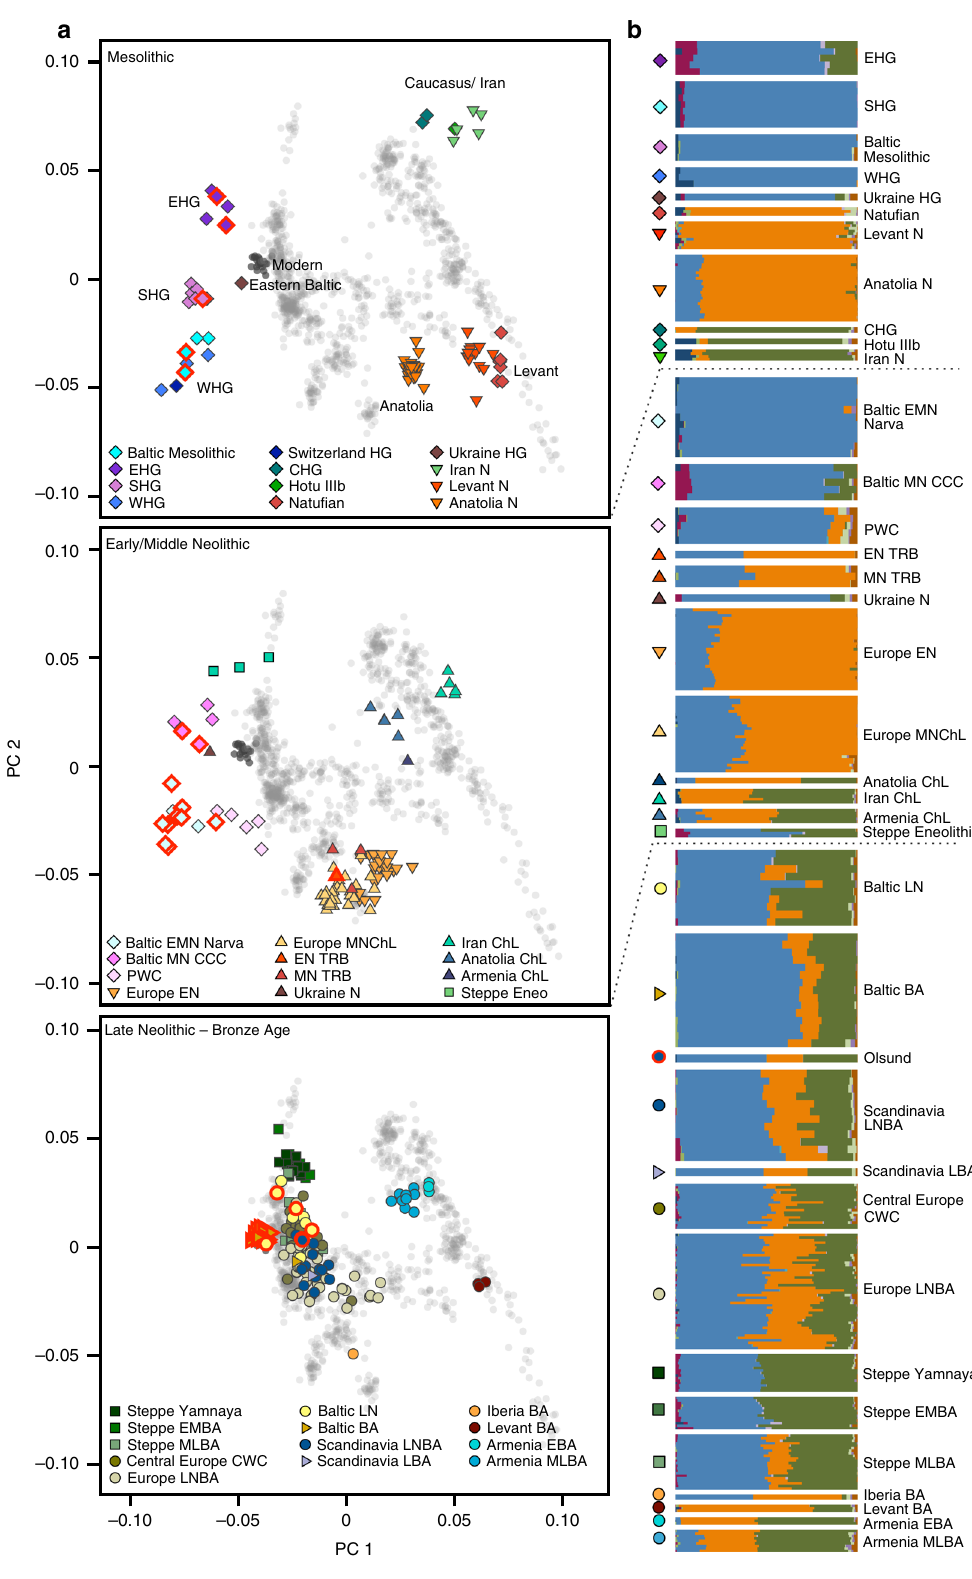
Fig. 2 PCA and ADMIXTURE analysis re fl ecting three time periods in Northern European prehistory. a Principal components analysis of 1012 present-day West Eurasians (grey points, modern Baltic populations in dark grey) with 294 projected published ancient and 38 ancient North European samples introduced in this study (marked with a red outline). Population labels of modern West Eurasians are given in Supplementary Fig. 7 and a zoomed-in version of the European Late Neolithic and Bronze Age samples is provided in Supplementary Fig. 8. b Ancestral components in ancient individuals estimated by ADMIXTURE ( k =